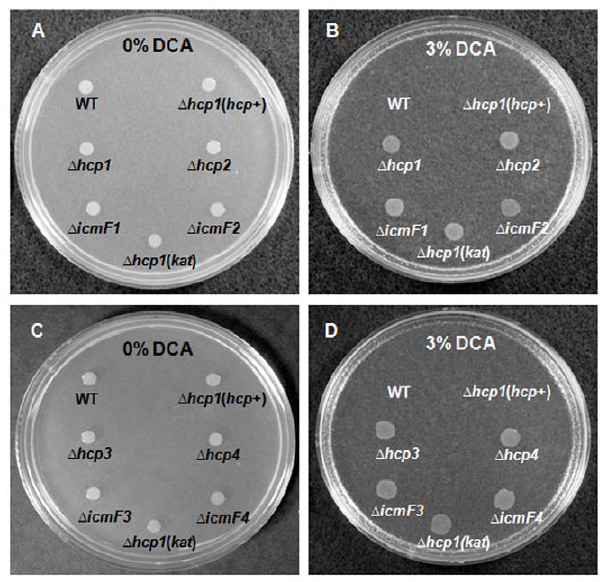
Figure 4. Growth responses of WT C.jejuni , D hcp and D icmF mutants, and the complemented D hcp1 strain, D hcp1 ( hcp + ), on agar free of or supplemented with 3% DCA. (A) WT, D hcp and D icmF mutants harboring cat ( hcp1 , hcp2 , icmF1 , icmF2 ), complemented D hcp1 strain, D hcp1 ( hcp + ), and the control D hcp1 mutant harboring kat ( D hcp1 ( kat )) grown on a DCA-free agar and (B) supplemented with 3% DCA. (C) WT, D hcp and D icmF mutants harboring kat ( hcp3 , hcp4 , icmF3 , icmF4 ), D hcp1 ( hcp + ) and D hcp1 ( kat ) grown on a DCA-free agar and (D) supplemented with 3% DCA.